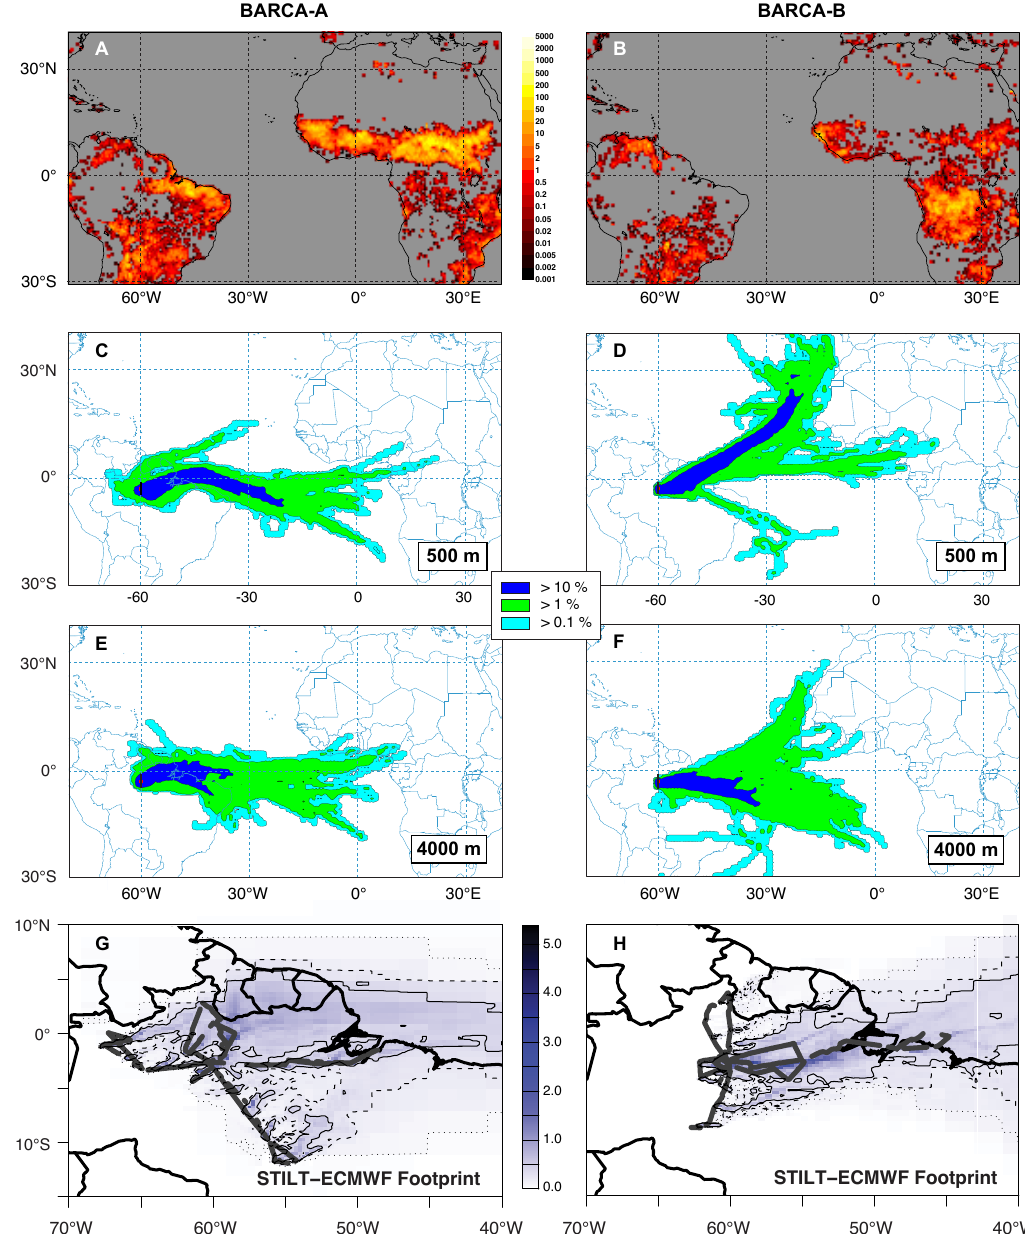
Fig. 2. The distribution of vegetation fires and atmospheric transport during BARCA-A (left) and BARCA-B (right). Panels (A) and (B) show the mean Fire Radiative Power (FRP), a proxy for the amount of biomass burned, over the campaign periods in units of mWm − 2 . The colors in panels (C–F) indicate the frequency of trajectories passing through the corresponding areas. The colors in panels (G) and (H) represent the influence of surface emissions on the concentrations at the receptor site in ppmµmol − 1 m 2